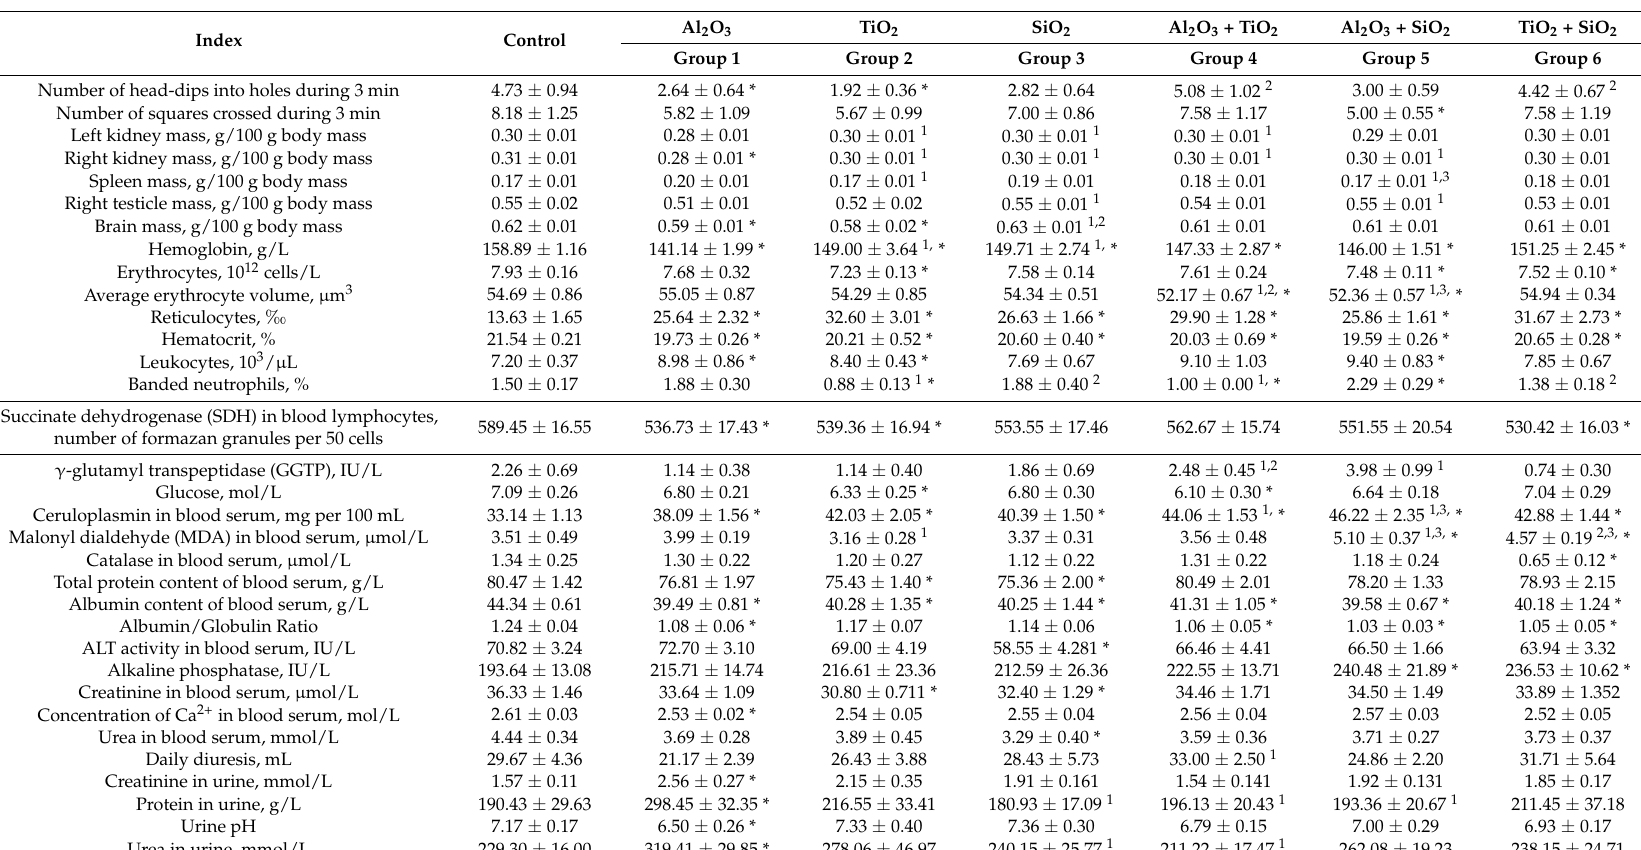
Table 2. Functional and Biochemical Indices of Rat Organism Status differing significantly from controls and/or those of other groups after 18 (during 6 Weeks) Intraperitoneal Injections of Suspensions of Various MeO-NP Species Administered Individually in Binary Combinations (x ± s.e.). The complete Table is given as Table S1 of Supporting Material; x, mean; s.e., standard